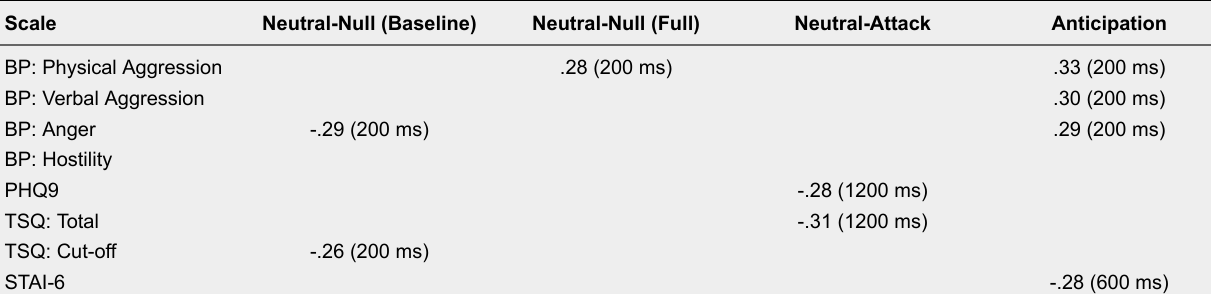
Significant Correlations Involving Contrast Scores and Questionnaire Data: B. Accuracy